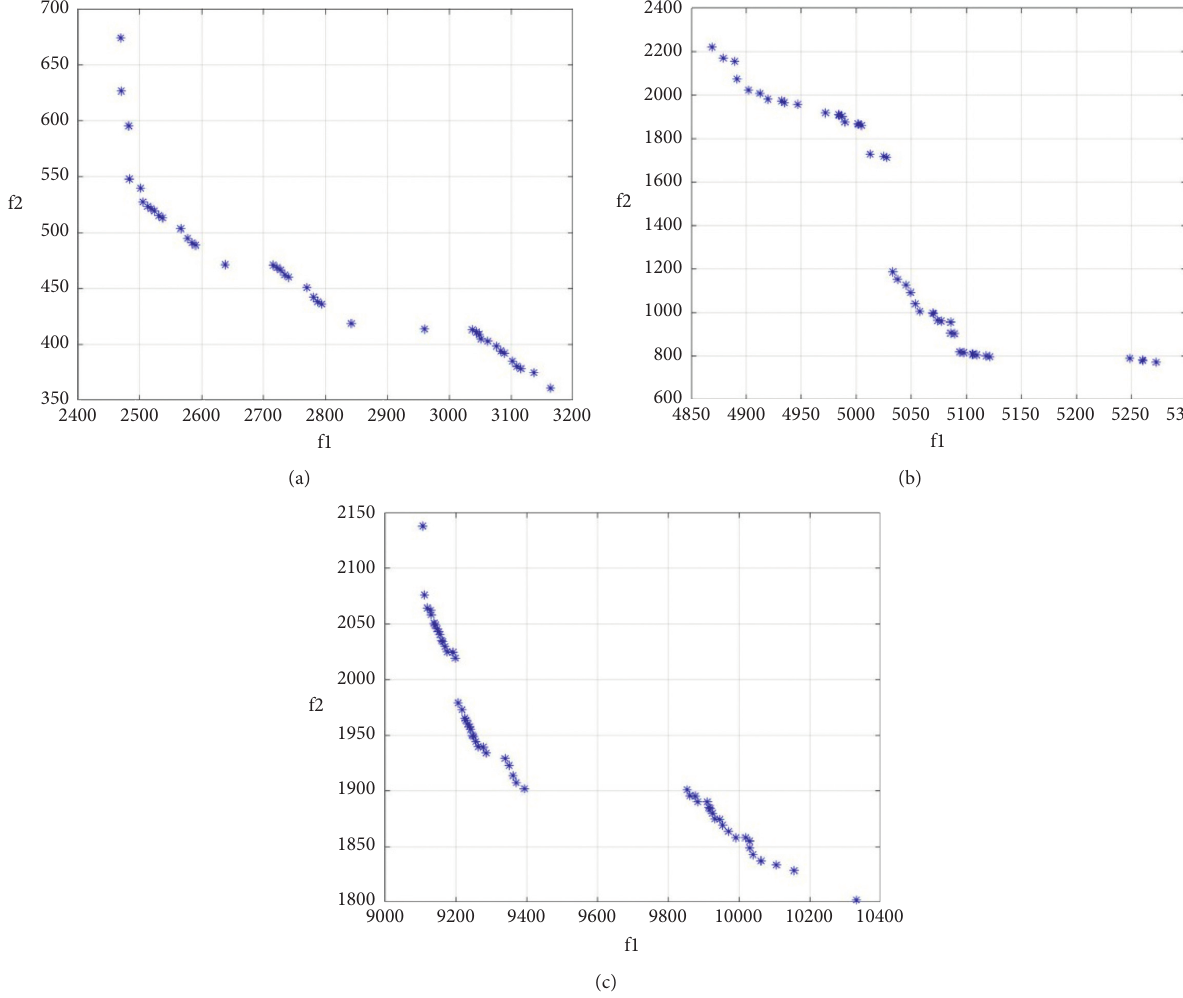
Figure 5: Pareto front. (a) Instance I. (b) Instance II. (c) Instance III.